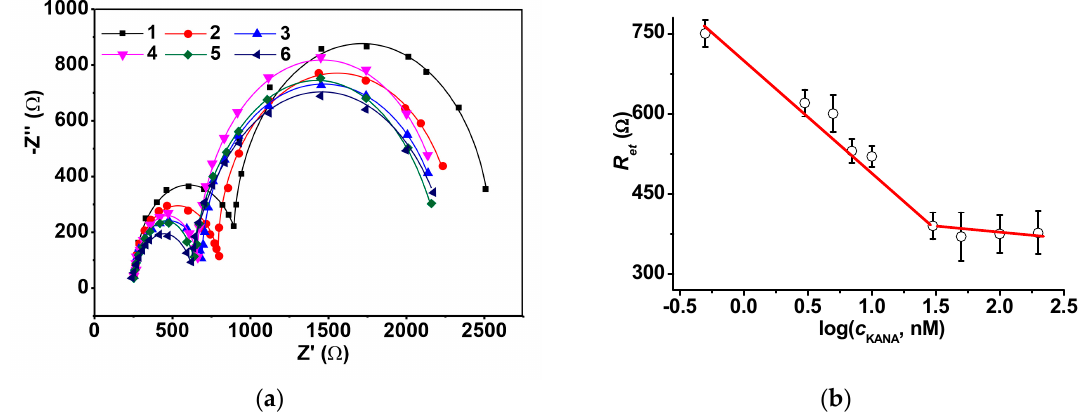
Figure 5. ( a ) The Nyquist diagram of the impedance spectra recorded on the GCE covered with the CB/chitosan and the OLA- cone /aptamer mixture (1:2 v / v ) after incubation in 0.5 (1), 3.0 (2), 7.0 (3), 10 (4), 30 (5), and 50 (6) nM KANA; ( b ) The dependence of the ( R et ) 1 value on the KANA concentration. Mean ± S.D. is presented for three individual aptasensors. Measurements in PB, pH = 7.0. The appropriate calibration (Equation (7)) is given below.